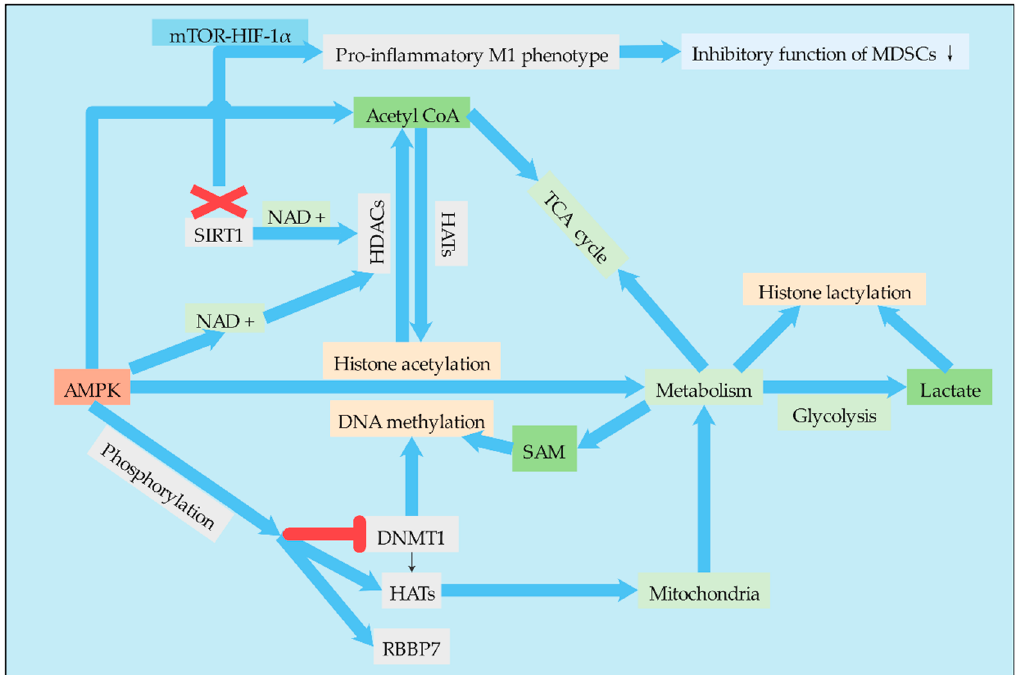
Figure 4. Connections between epigenetic modification and metabolism in MDSCs. Acetyl-CoA, SAM, and lactate, as important substrates and group donors of epigenetic modification, are important pivot substances connecting metabolism and epigenetic modification and have important regulatory effects on epigenetic modification. AMPK, as an energy receptor, can not only regulate metabolism but also regulate some corresponding epigenetic modifications through the regulation of epigenetic modification enzymes such as DNMT, HATs, and HDACs. Moreover, AMPK regulates the metabolism of MDSCs by regulating histone acetylation and DNA methylation.